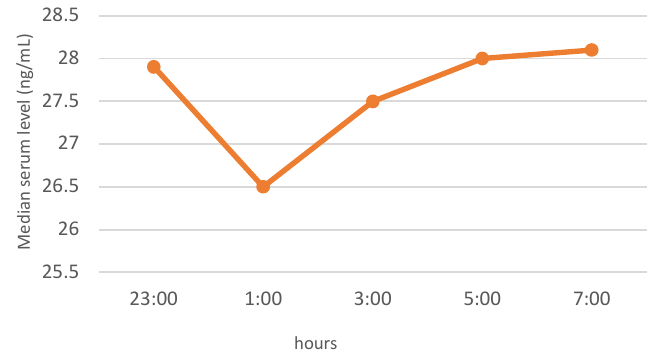
Figure 2. Night profile of leptin in the study group.